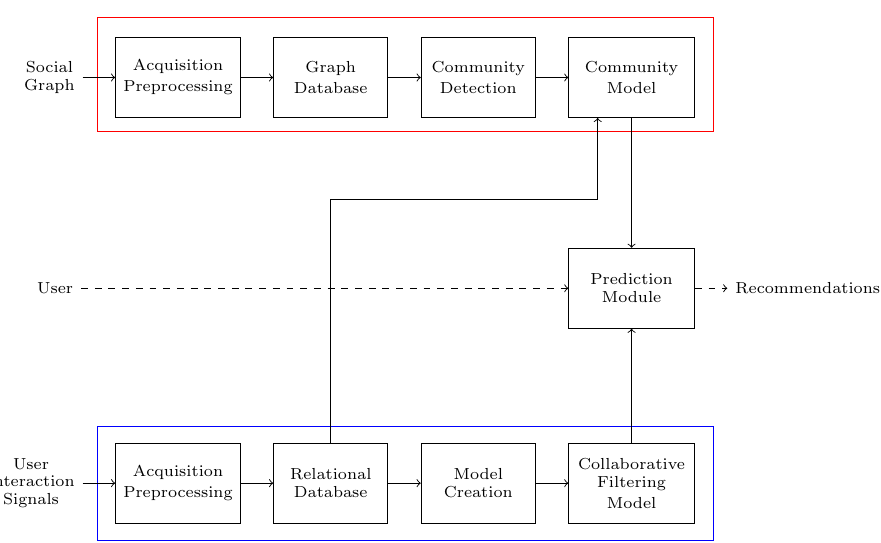
Fig. 3. General architecture of a Recommender System with social enhancement to alleviate the cold- start